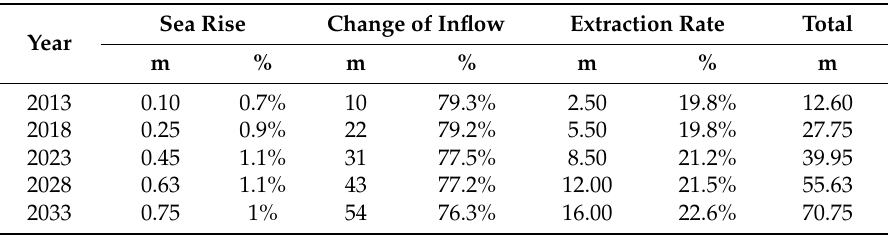
Table 6. Proportion of impact for each parameter in scenario (A).